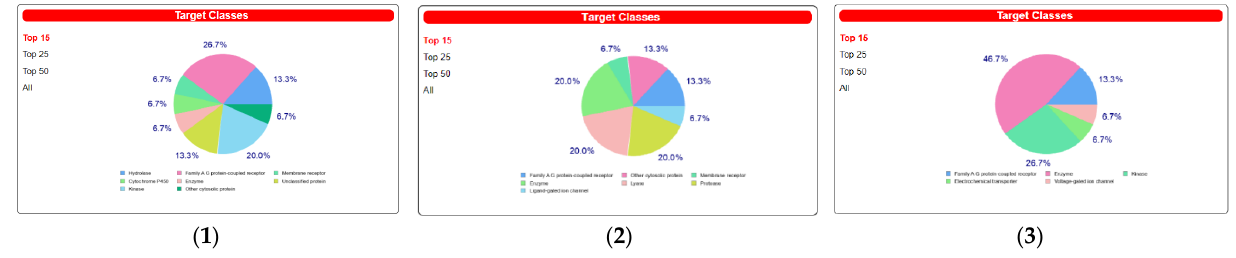
Figure 6. Chemical structures of palmatine ( 1 ), metformin ( 2 ) & glimepiride ( 3 ).